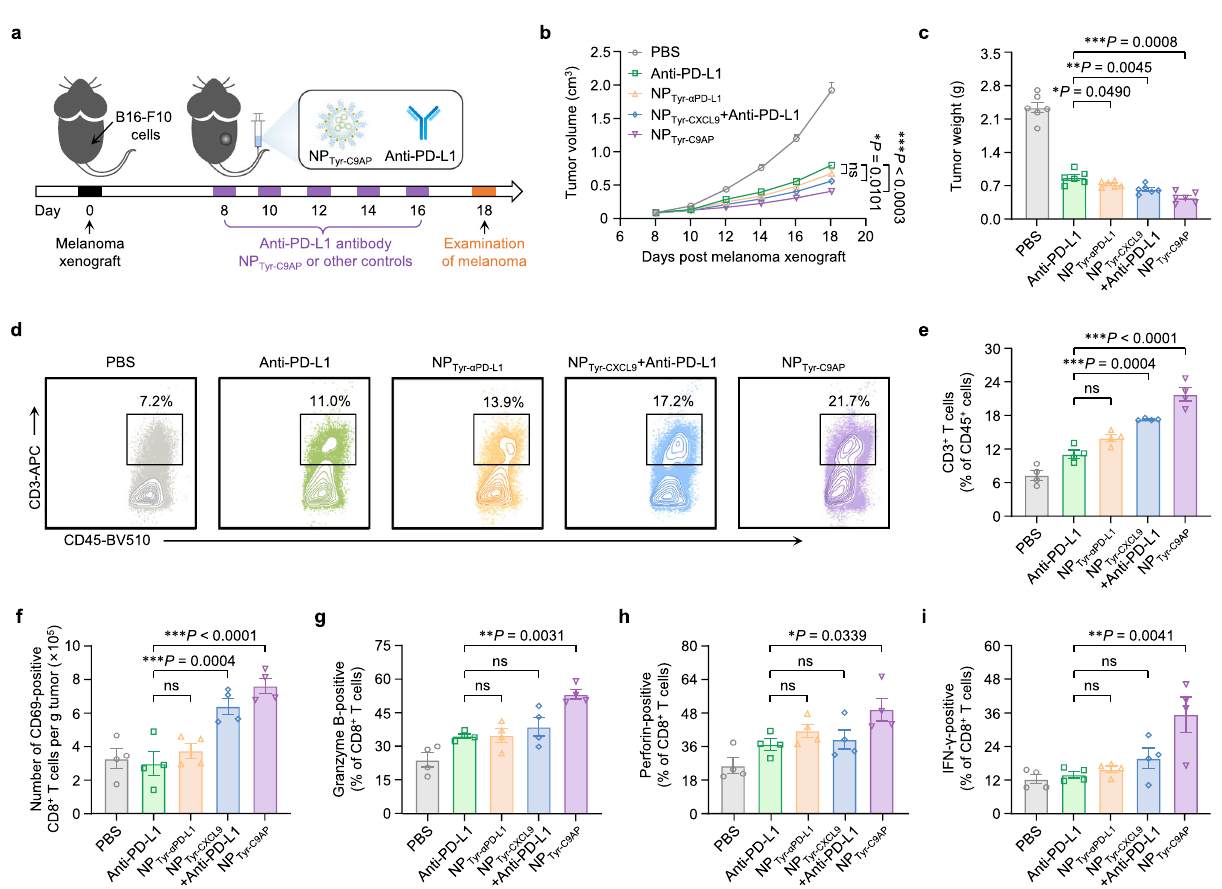
Fig. 6 | NP Tyr-C9AP exhibits superior ef fi cacy to systemically injected anti-PD-L1 antibody. a Therapeuticscheme. MicebearingB16-F10melanomaweretreatedby fi ve i.v . injections of NP Tyr-C9AP , anti-PD-L1 antibody or other controls. b , c Tumor growth curves ( b ) and fi nal tumor weights ( c ) of the B16-F10 melanoma-bearing miceafterdifferenttreatments( n =6micepergroup). d , e Flowcytometryplotsof CD3 + T cell percentages in CD45 + cells ( d ) or statistical percentages of CD3 + T cells ( e ) in melanoma after different treatments ( n =4 mice per group). f Numbers of CD69-positiveCD8 + Tcellsinmelanoma. g – i GranzymeB-( g ),perforin-( h